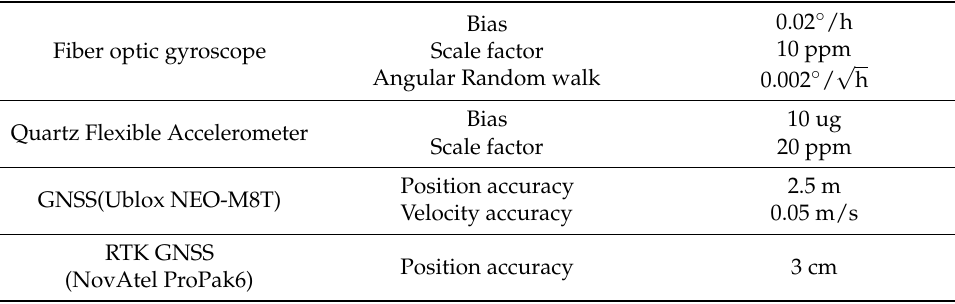
Figure 5. Data acquisition vehicle platform. Table 1. The parameters of the sensors.